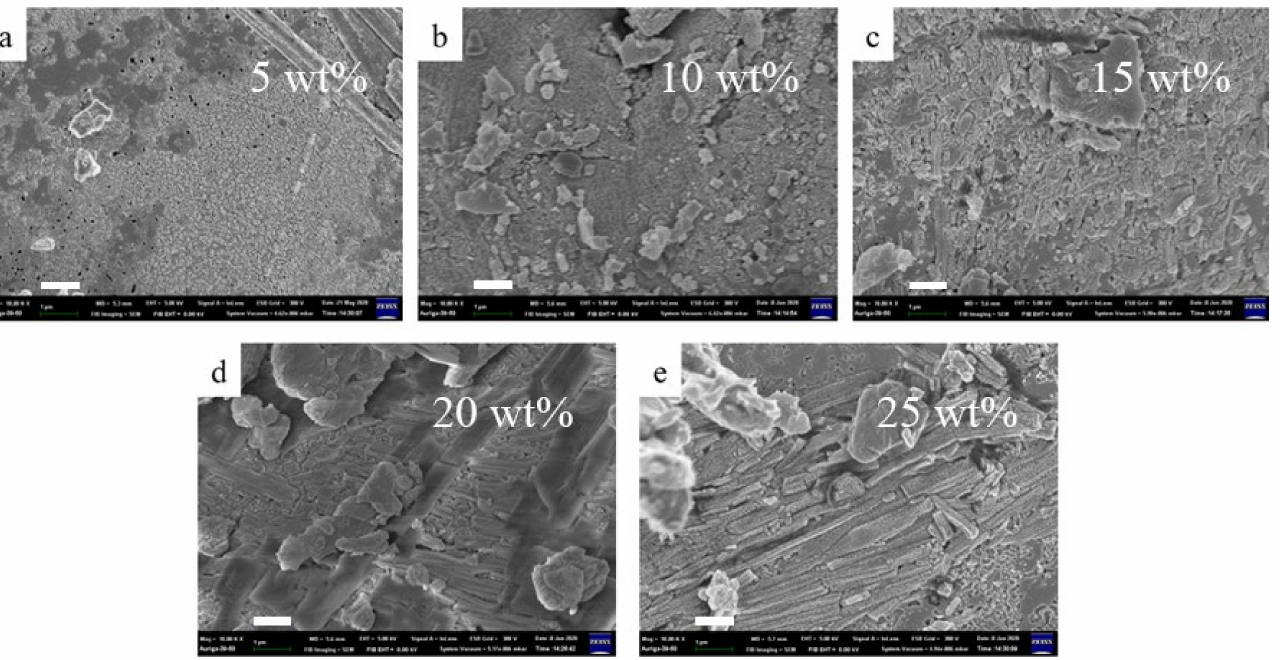
Figure 8. SEM images of intumescent flame-resistant coatings after thermal heating with the optimum ratio of sodium silicate, ammonium polyphosphate, pentaerythritol, plus ( a ) 5, ( b ) 10, ( c ) 15, ( d ) 20 and ( e ) 25 wt.% of Al(OH) 3 , respectively. (scale bar = 1 µ